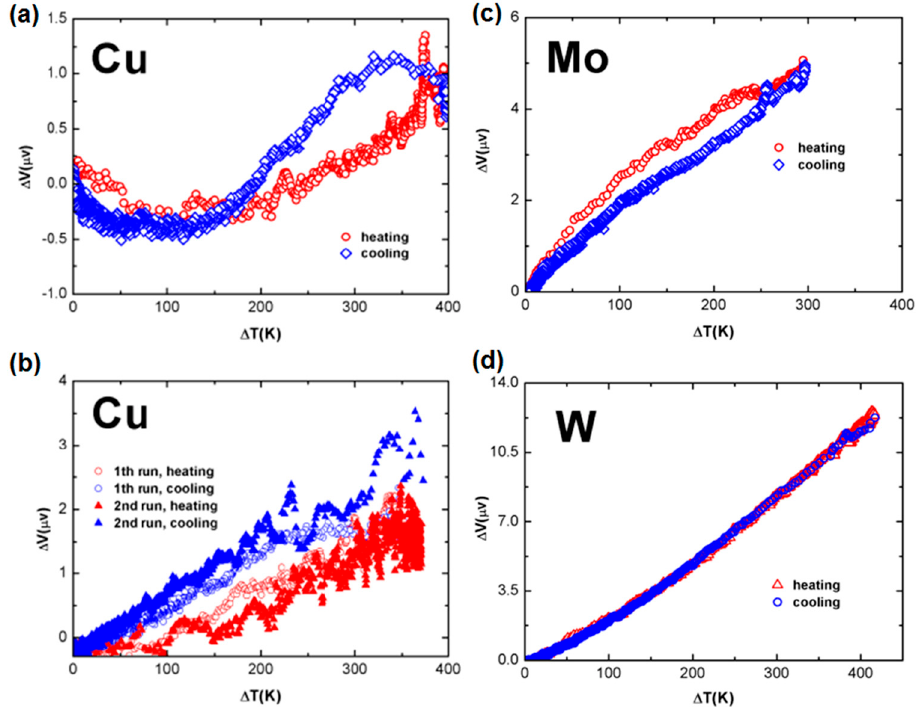
Figure 3. Measurement results of grinded samples made from ( a ) a 2.0 mm diameter pure Cu wire sample; ( b ) a 1.0 mm diameter pure Cu wire sample; ( c ) a 0.5 mm diameter pure Mo wire; and ( d ), a